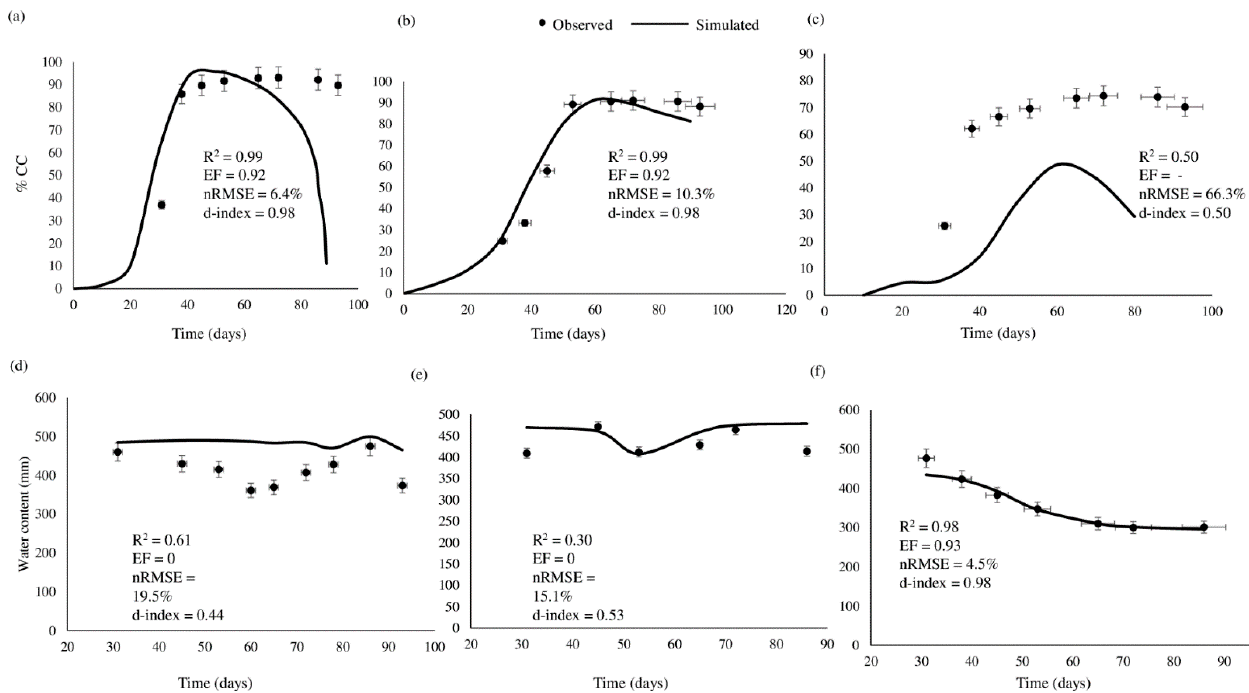
Figure 4. Canopy cover ( CC ) for ( a ) 100% ET c , ( b ) 75% ET c , and ( c ) 55% ET c and soil water content (SWC) for ( d ) 100% ET c , ( e ) 75% ET c , and ( f ) 55% ET c irrigation regimes during calibration.